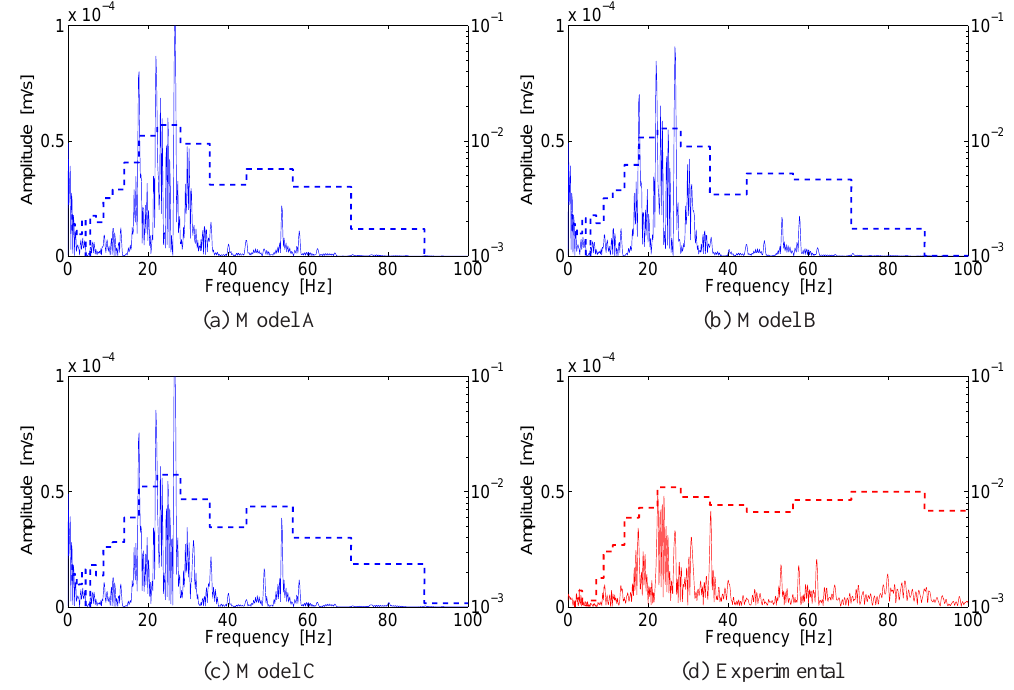
Figure 17. Predicted and measured frequency content (spectra in solid line and one-third octave band in dashed line) of vertical ground velocity at 9m from the track.